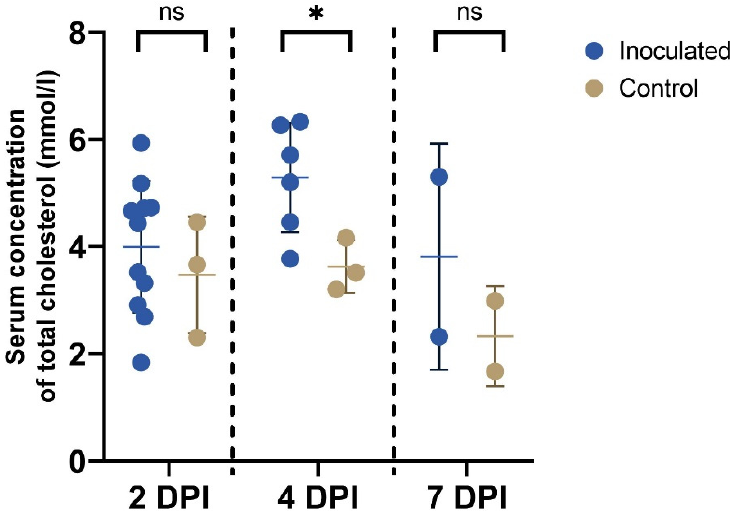
Figure 3. Concentration of total cholesterol (mmol/l) in serum samples. The number of tested samples (non-hemolyzed) was 11, 6, and 2 for inoculated animals and 3, 3, and 2 for control animals at 2, 4, and 7 DPI, respectively. Three separate T tests were performed, one for each day. There was a significant difference between inoculated and control animals at 4 DPI ( p = 0.035, marked with *), but not at 2 or 7 DPI (marked with ns). The middle line and the bars indicate the mean ± SD. The figure was created with GraphPad Prism.